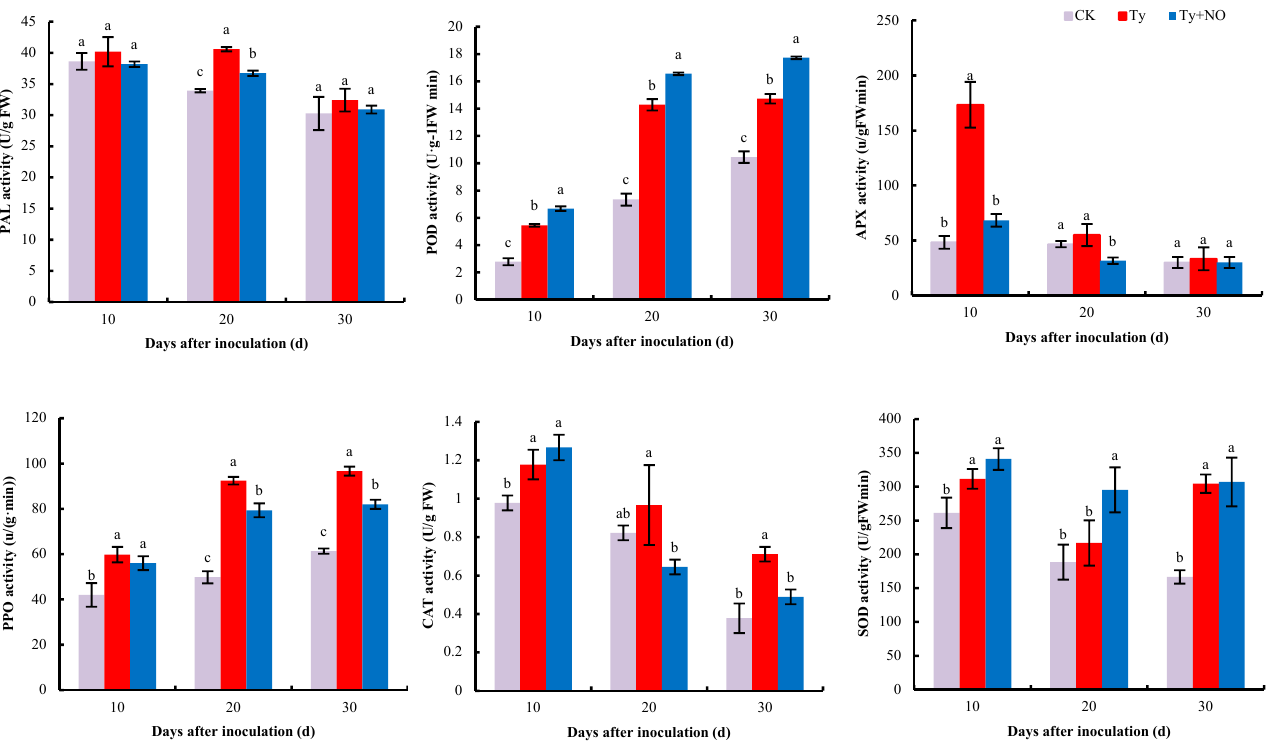
Figure 11. Regulation of antioxidant and defense enzyme activities by exogenous NO in diseased plants. Different lowercase letters indicate significant differences between treatments, p < 0.05. Same below.